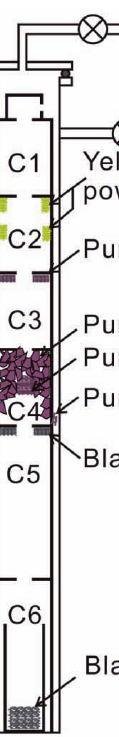
Figure 6. It was confirmed that pure TiCl 3 condensed in